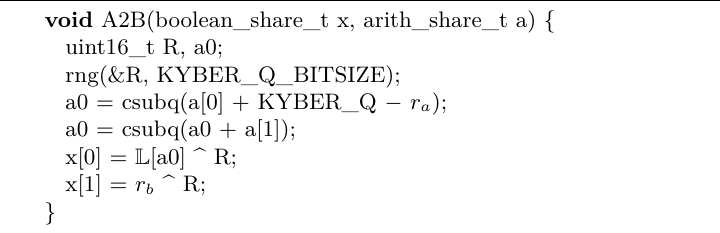
Figure 5: LUT-based arithmetic to Boolean version based on